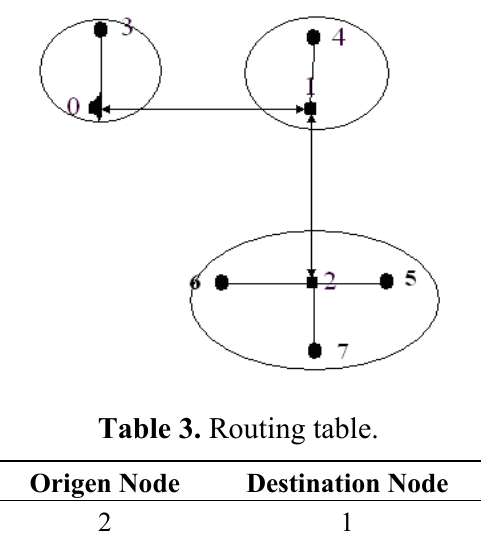
Figure 11. Global network of this study.